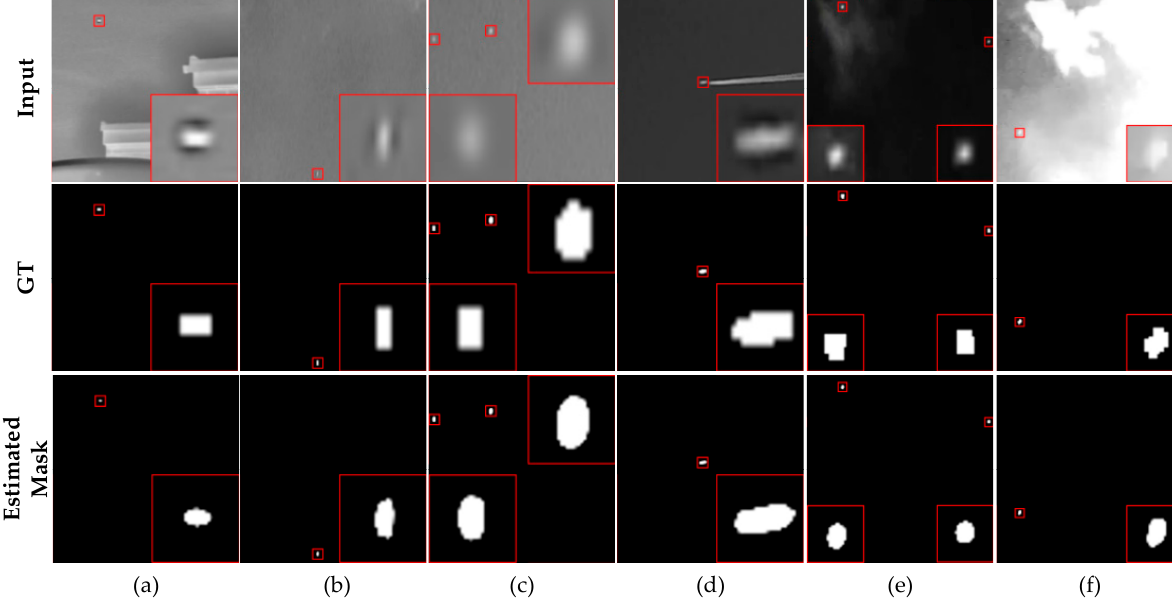
Figure 10. ( a – f ) Input image samples, a common ground truth mask (manually labelled), and output of EAAU-Net trained on the SIRST dataset. Our method can even produce more accurate segmentation results than manually labelled ground truth masks.